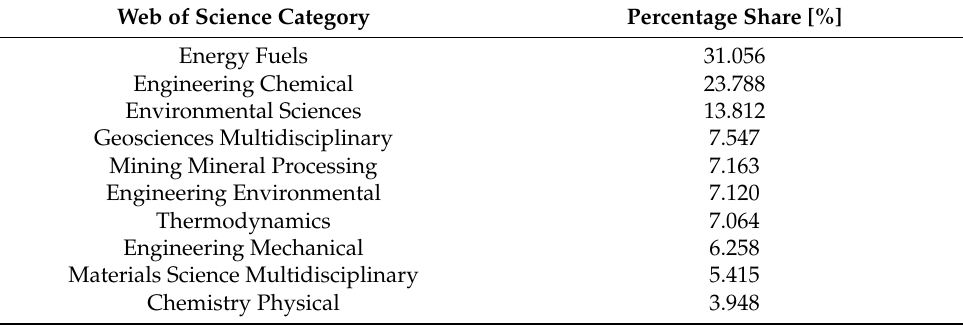
Figure 12. Most frequent WoS categories. Table 8. Top 10 most frequent Web of Science